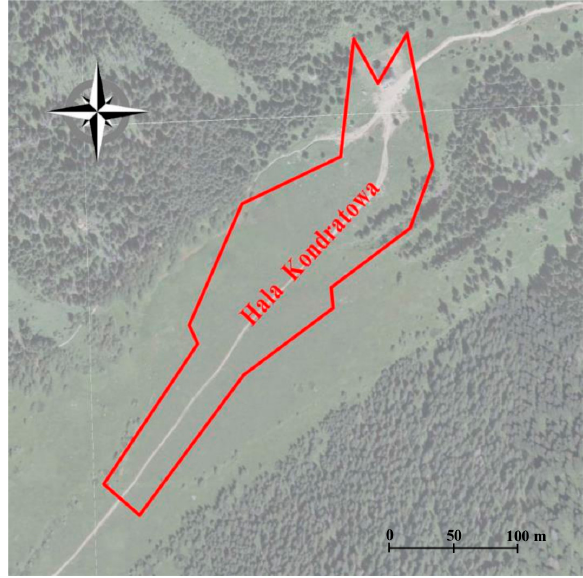
Figure 6. Location and spatial reach of the area where TLS was carried out (Hala Kondratowa) (source: authors’ own study based on [61]).